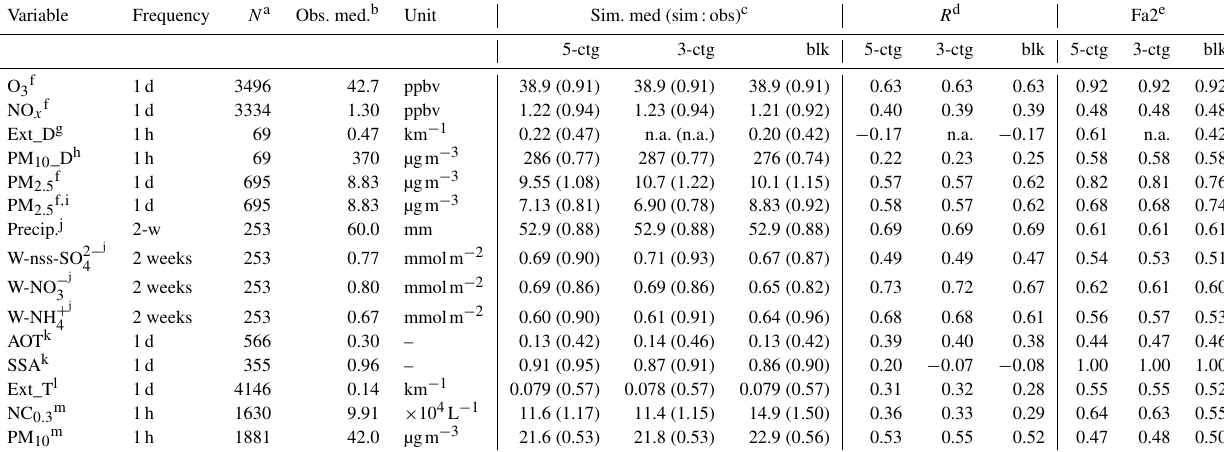
Table 4. Comparative statistical analysis of observed (obs.) and simulated (sim.) variables. Here, “5-ctg” and “3-ctg” indicate the five- category and three-category methods, respectively, and “blk” indicates the bulk method. Variable